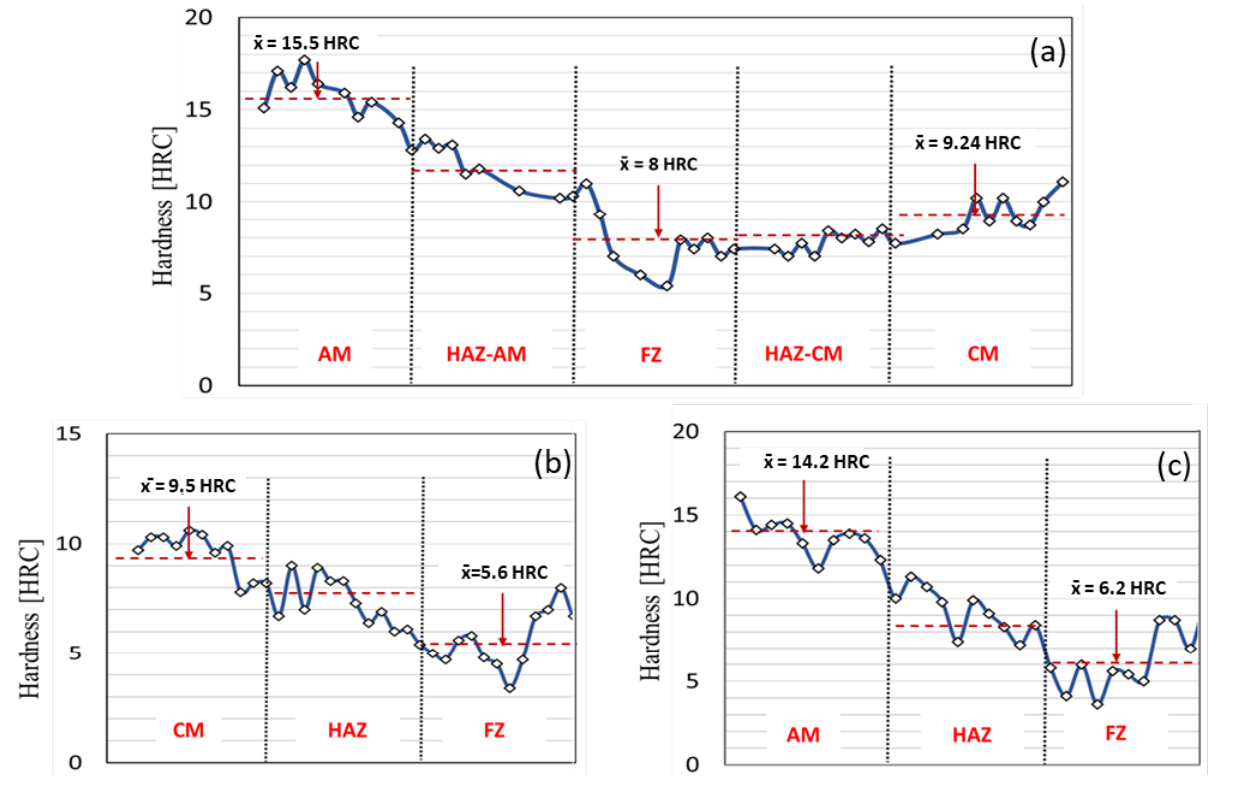
Figure 12. Microhardness profile (HRC) of cross-section welded samples, ( a ) CM-AM configuration, ( b ) CM-CM configuration, ( c ) AM-AM configuration.